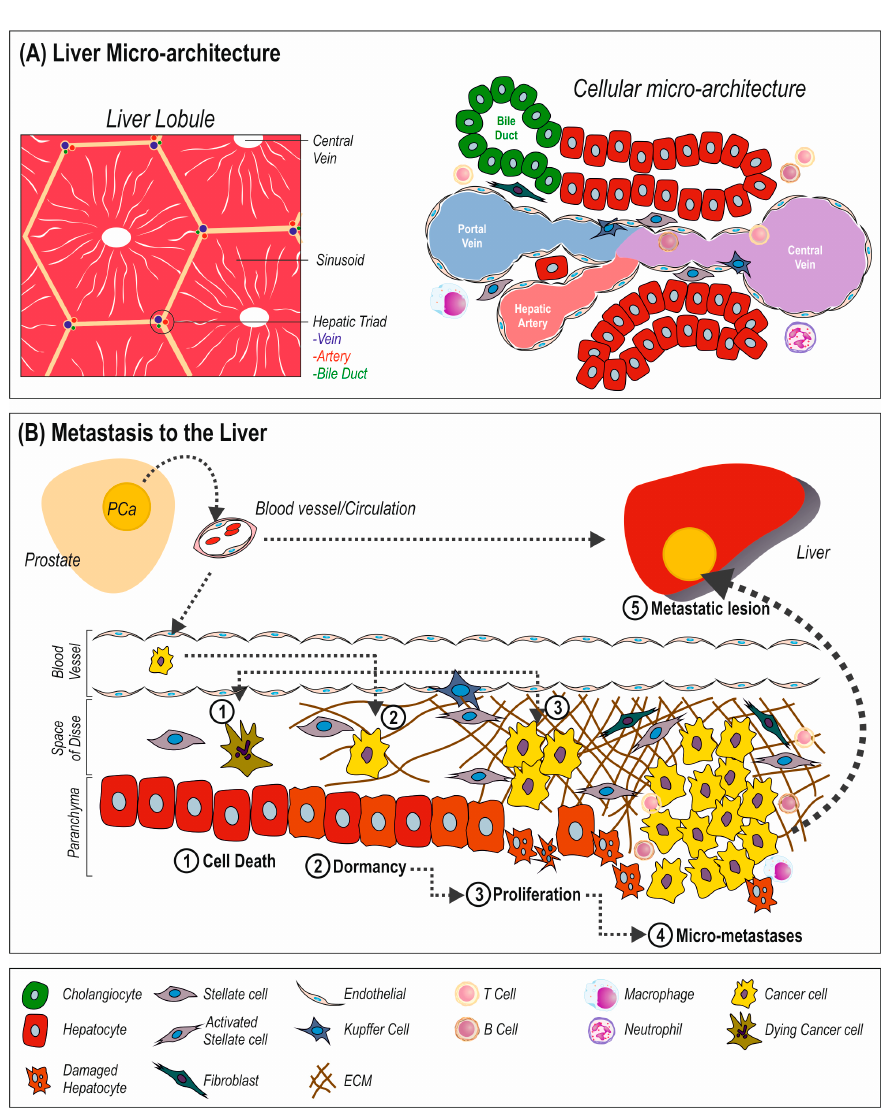
Figure 1. ( A ) Liver Lobule Cellular Microenvironment. The liver is comprised of hepatic lobules, which are the microscopic hexagonal subunits of the liver. These consist of a central collecting vein, hepatocyte lined sinusoids leading to hepatic triads, a collection of three ducts; hepatic artery, portal vein, and bile duct. Between the endothelial cells and either hepatocytes or cholangiocytes/bile ducts, is the space of Disse, a region where mesenchymal cells reside, such as stellate cells, dendritic cells/immune cells, and fibroblasts. ( B ) Metastatic colonization of the liver. Escaping from the primary site, cancer cells invade the circulatory system, through which they navigate to the liver. Once extravasated from hepatic blood vessels and in the liver, cancer cells can undergo cell death or they can remain dormant. From dormancy, cancer cell proliferation can be activated, allow for the formation of micro-metastases, which with continued proliferation become macroscopic metastatic lesions. There is an associated change in the resident cells, with damage to the hepatocytes, increase in ECM due to activation of stellate cells and recruitment of fibroblasts. There is also a potential influx of immune